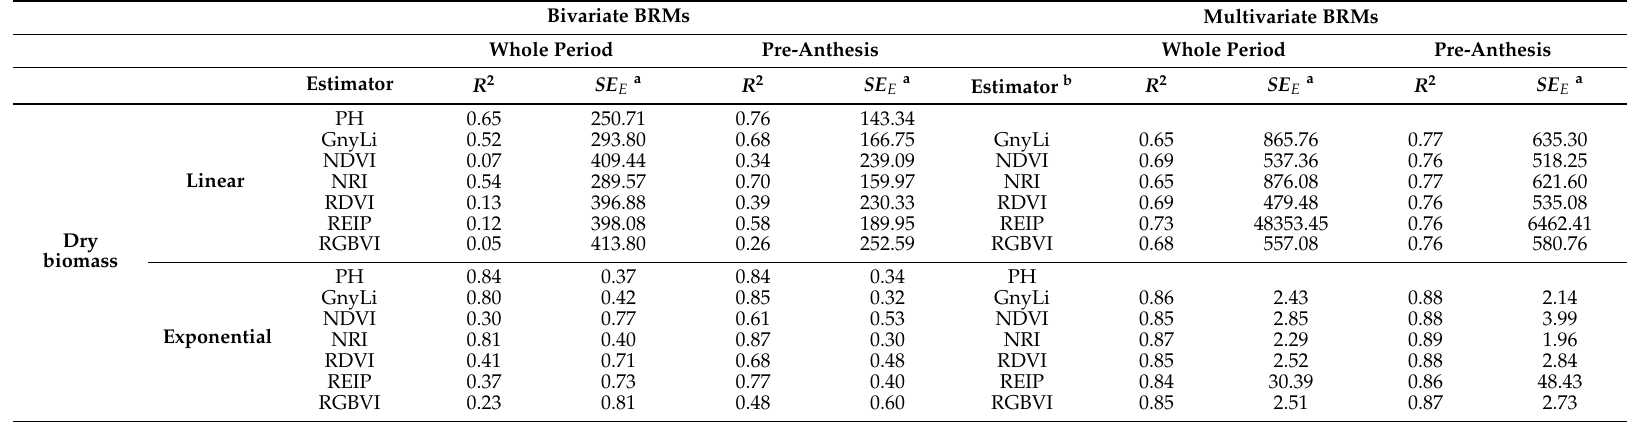
Table 2. Correction of Table 5 [1]. Statistics for the model calibration as mean values of the four subset combinations ( R 2 : coefficient of determination; SE E : standard error of the